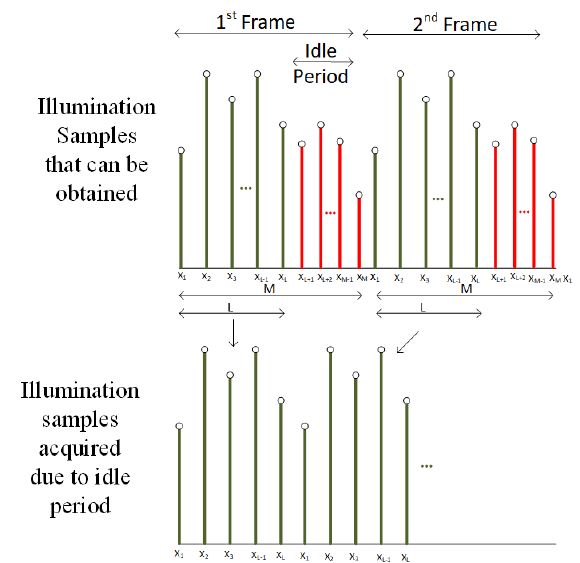
Figure 3. Rolling Shutter Sampling Mechanism.